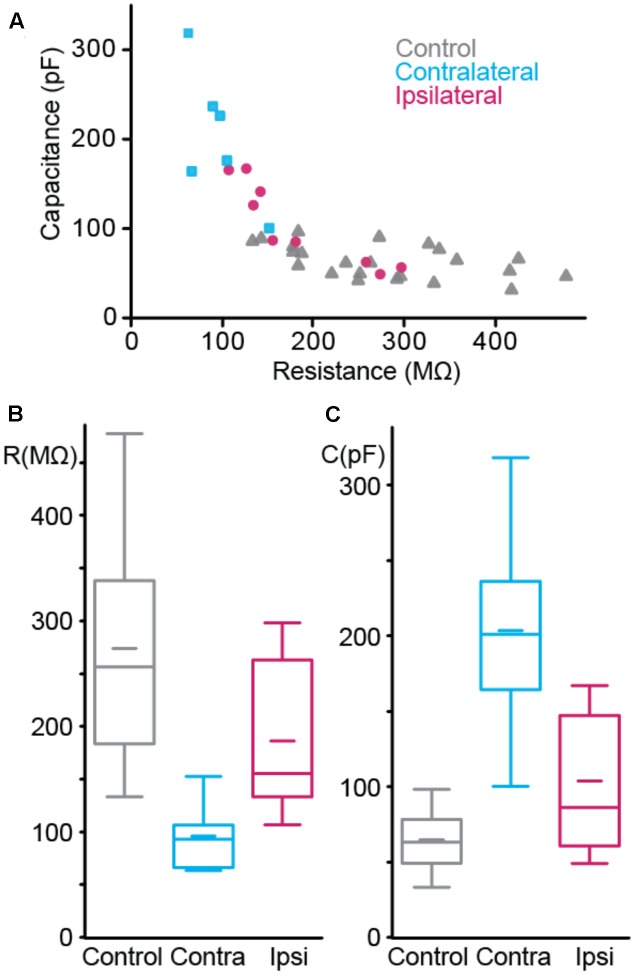
Passive membrane properties of interneurons. (A) Resistance vs. capacitance. (B,C) Boxplot of resistance (B) and capacitance (C). nCTRL = 22 interneurons, nCONTRA = 6, nIPSI = 9.